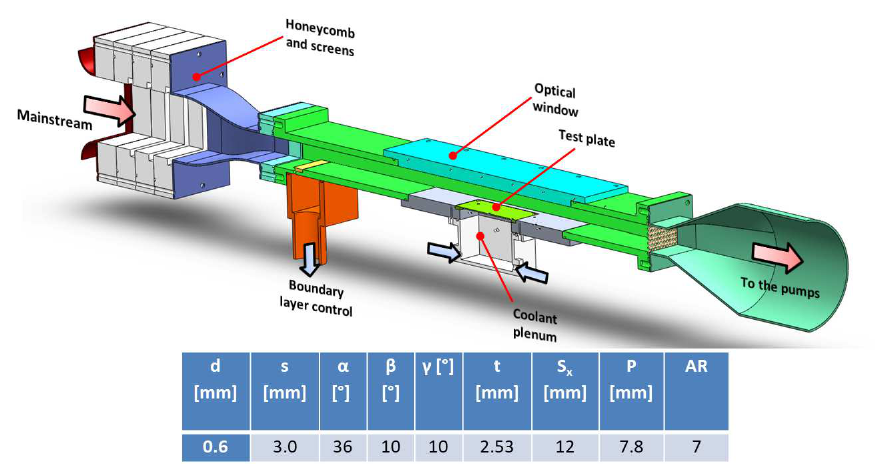
Figure 3. Sketch of the flat plate test rig and film-cooling geometric parameters.